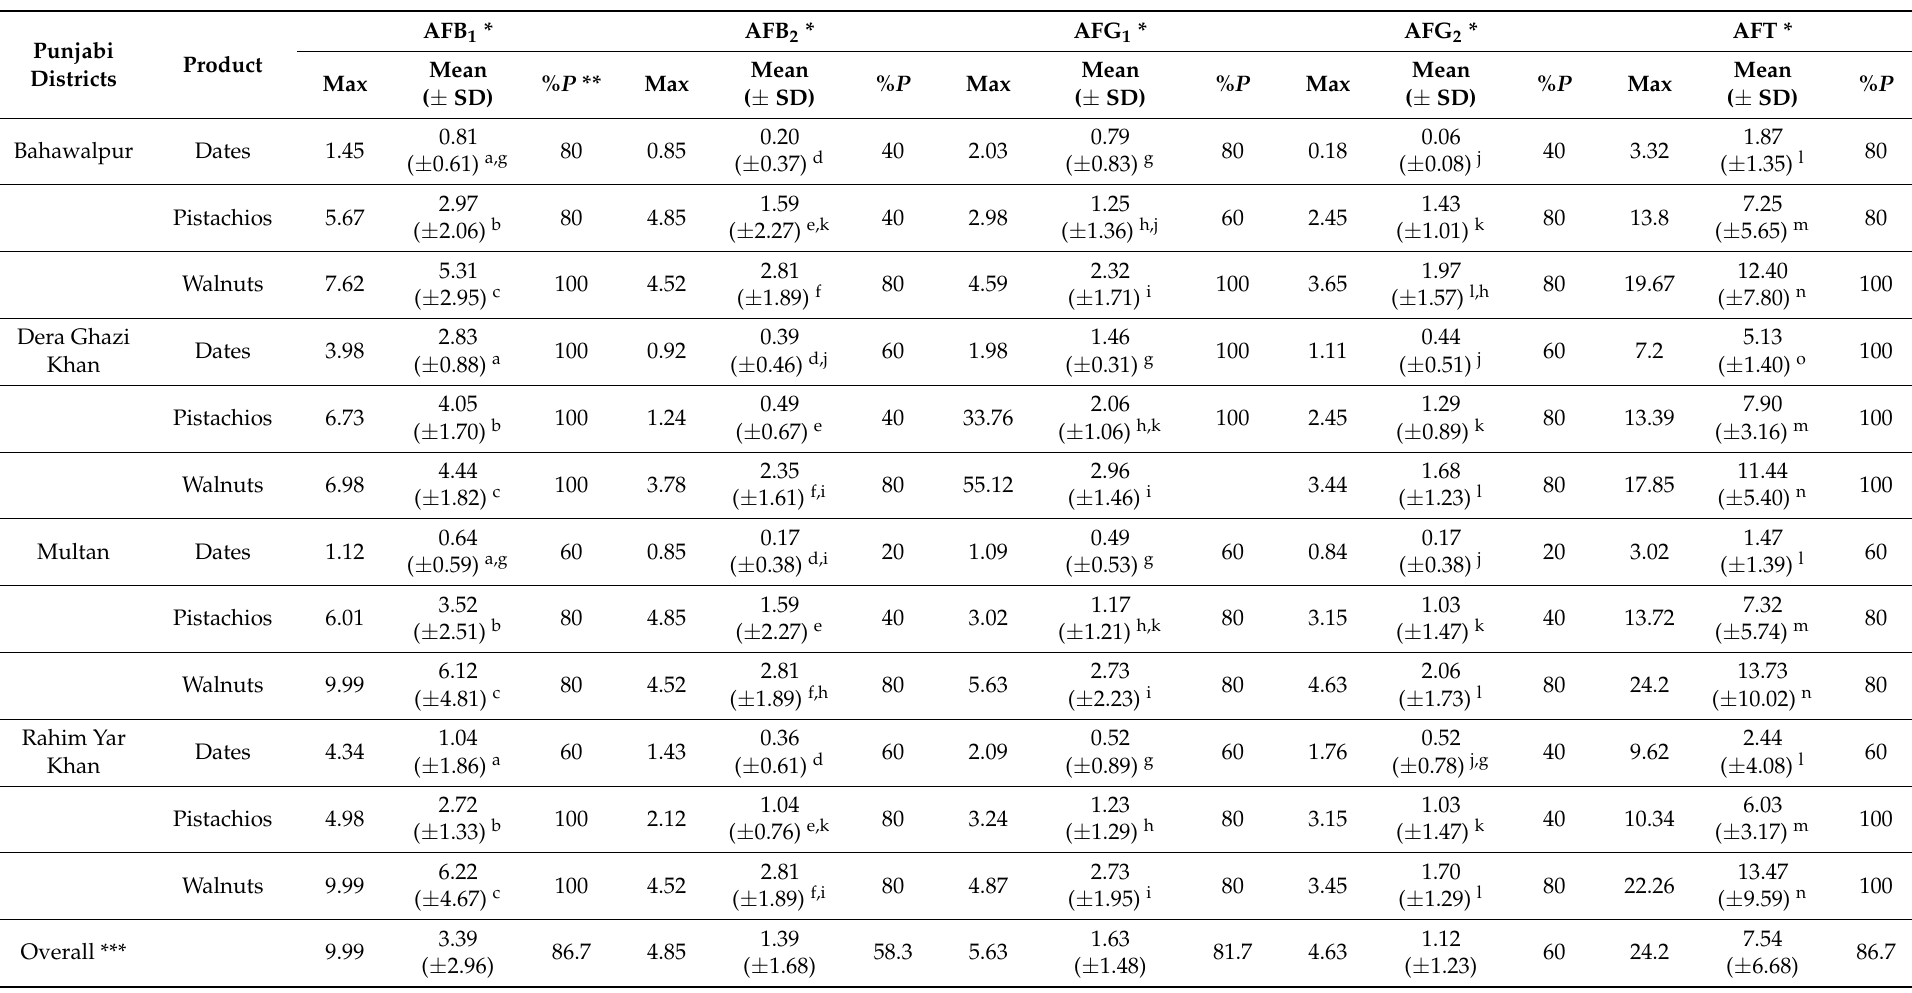
as defined in Table 1. Note: the minimum values for all aflatoxins are below the limit of detection (LOD); the LOD and the limit of quantification (LOQ) values are presented in Table